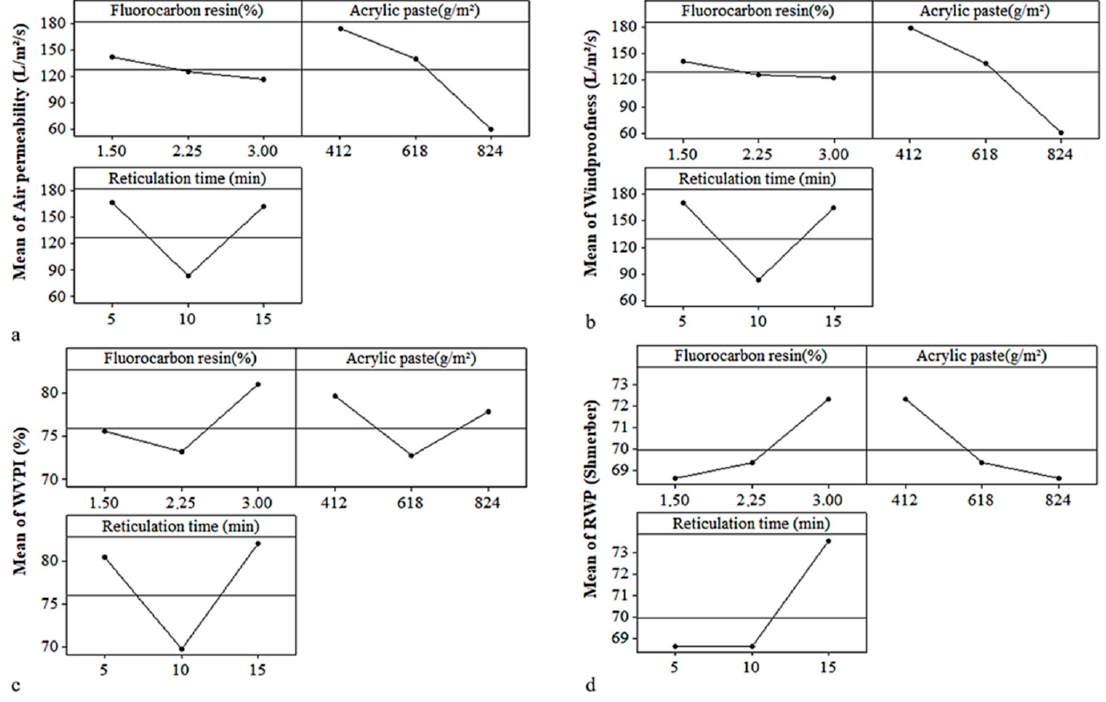
Figure 1. Main effect plots of: ( a ) air permeability (L·m − 2 ·s − 1 ); ( b ) windproofness (L·m − 2 ·s − 1 ); ( c ) WVPI (%); and ( d ) RWP (Schmerber). ( c ) WVPI (%); and ( d ) RWP